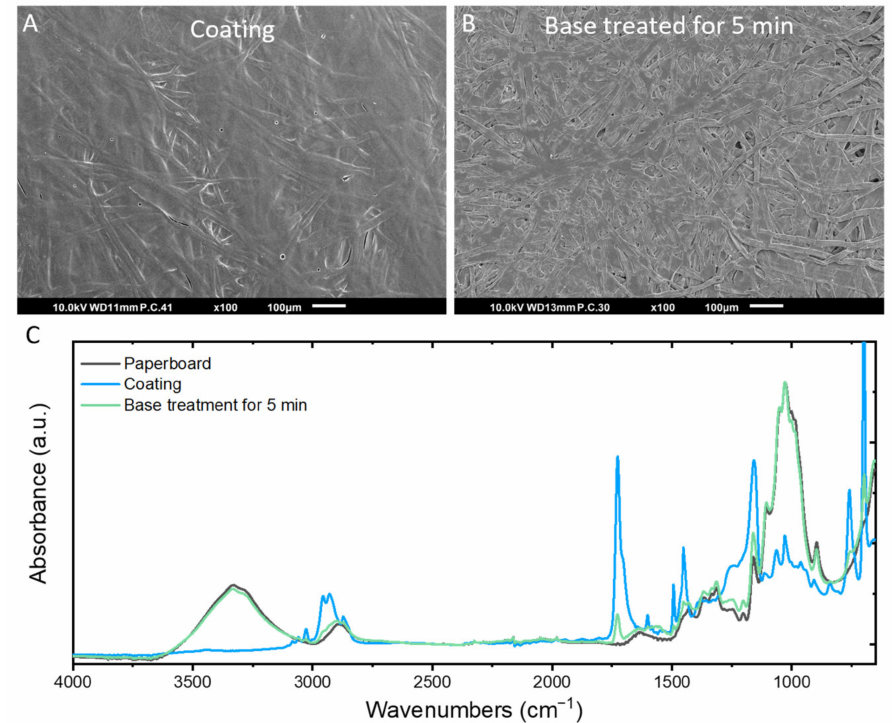
Figure 6. SEM images of the ( A ) initial coating on paperboard and ( B ) base-treated coating (0.1 M NaOH (aq) for 5 min) on paperboard. ( C ) Corresponding FTIR spectra of paperboard, coating and base-treated coating.